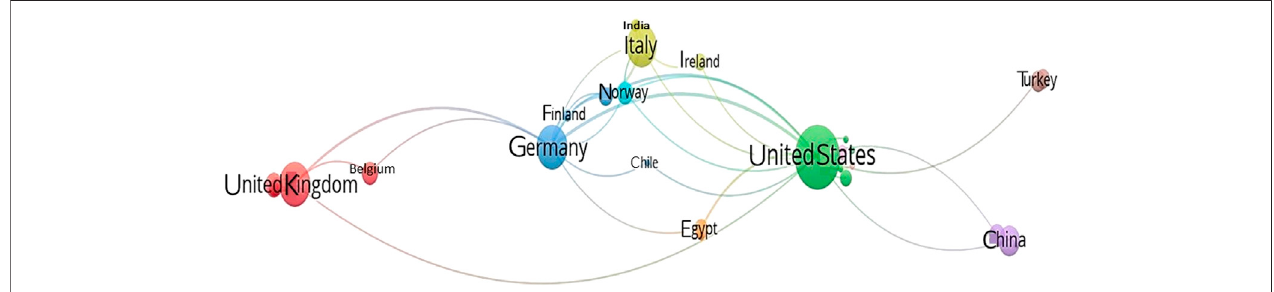
FIGURE 5 | Network map showing the international collaboration based on publications in the fi eld of radiotherapy and male reproductive research.